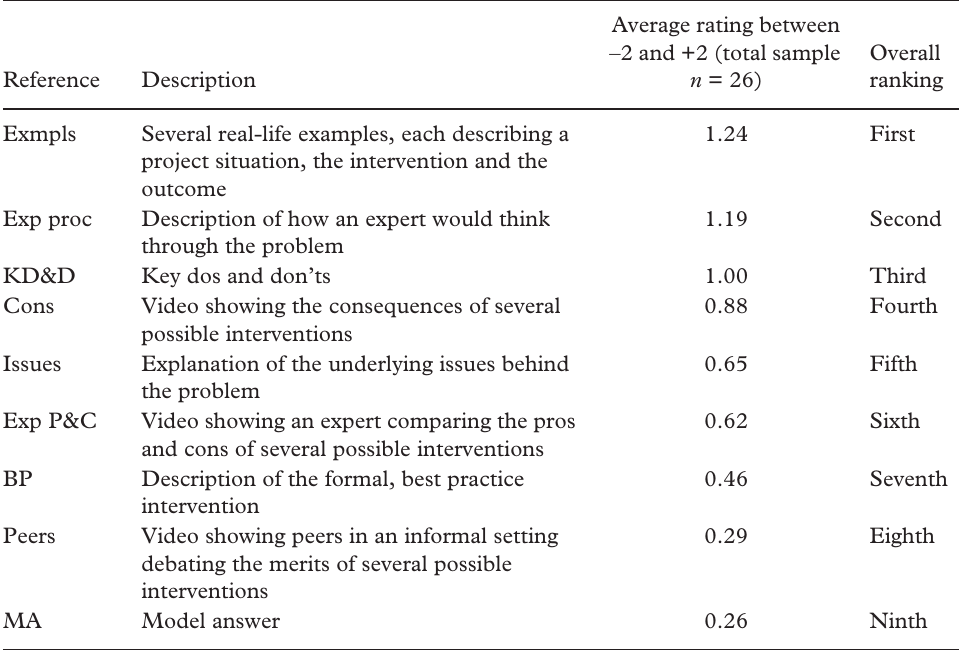
Table 4. Description, average ratings and overall ranking of nine non-verificational feedback